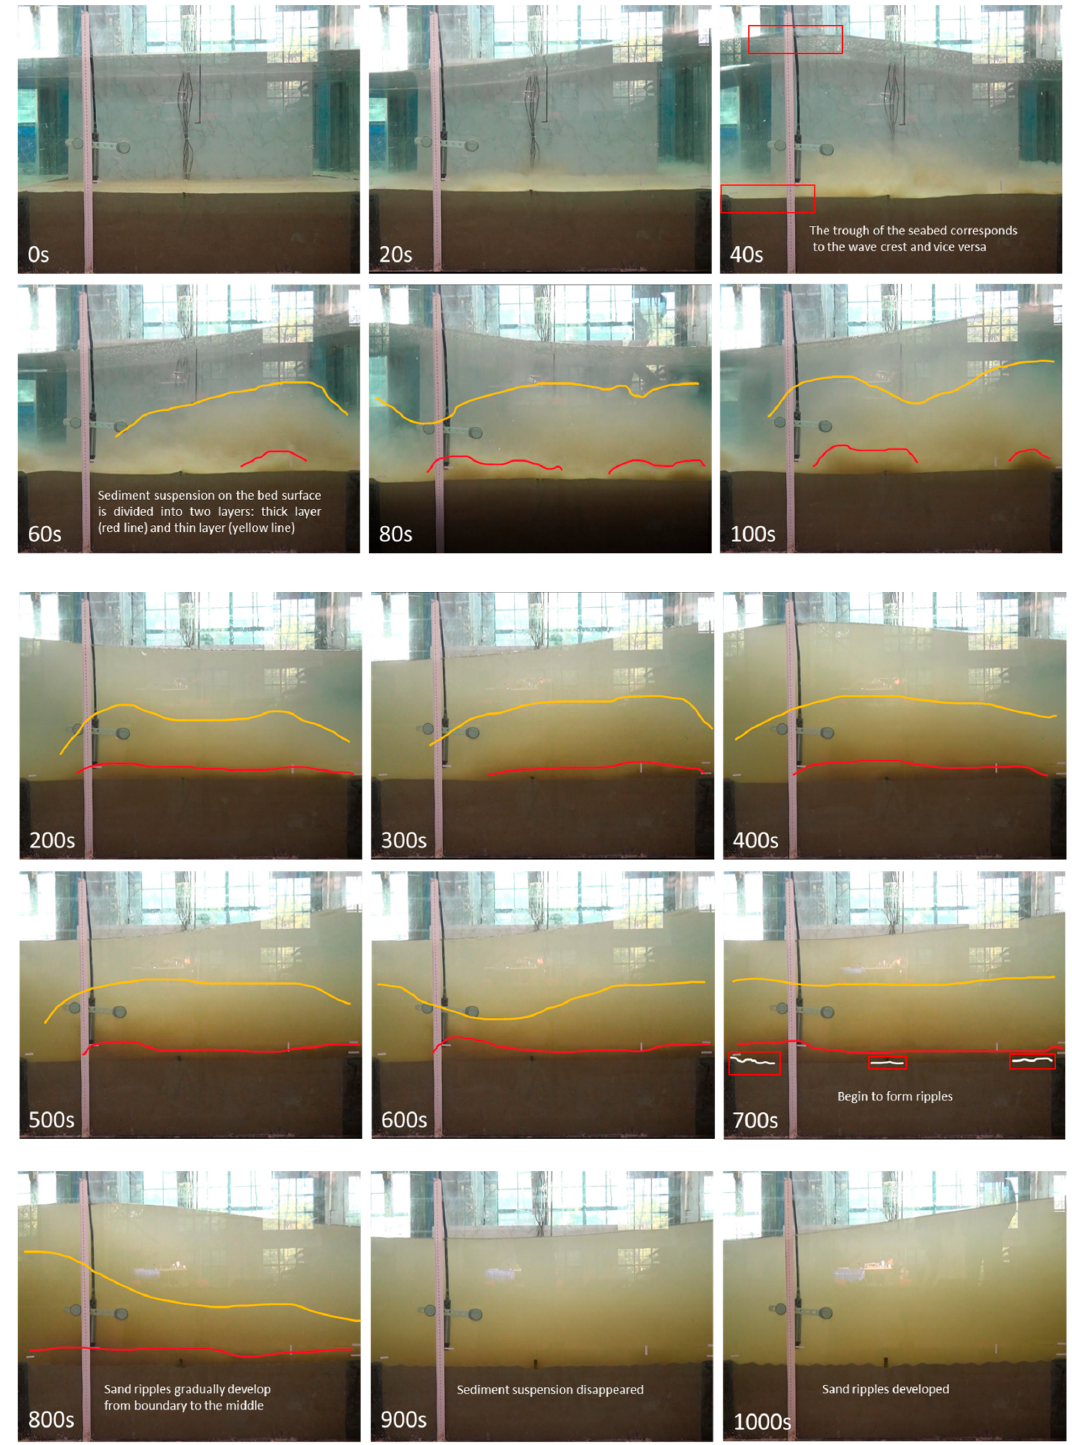
Figure 7. Liquefaction and consolidation of CC0.5 seabed.